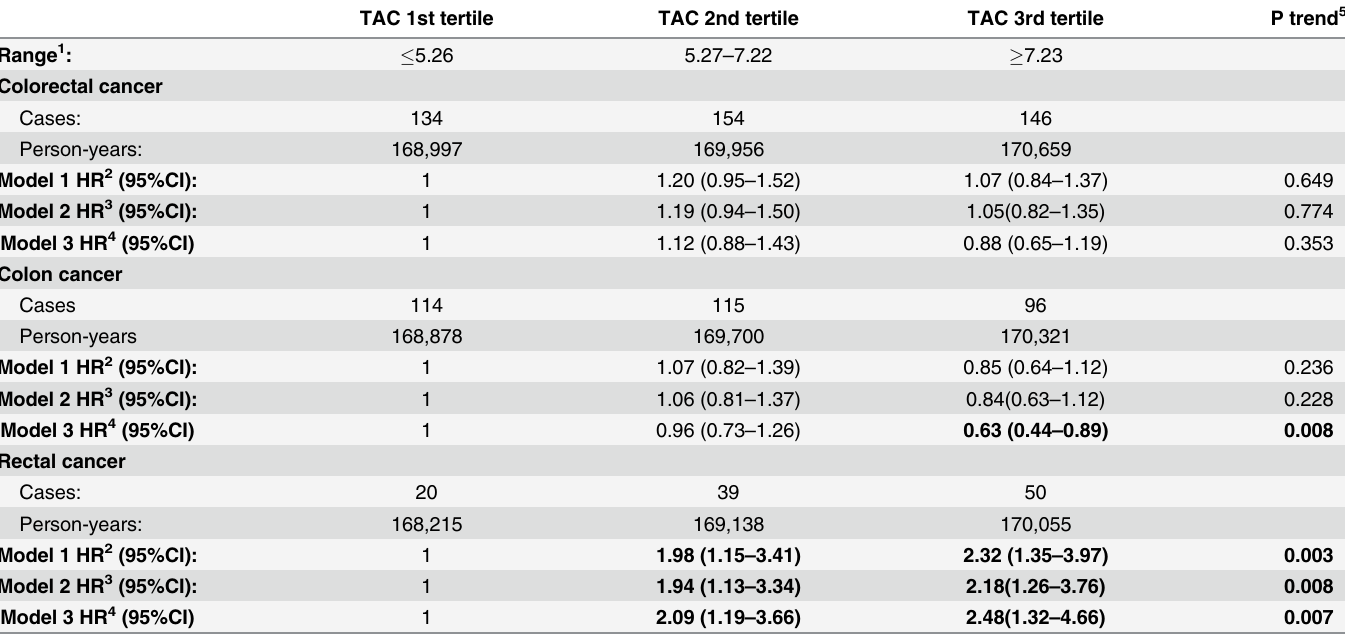
Table 2. HRs for developing colorectal, colon and rectal cancer by increasing tertiles of dietary TAC. TAC 1st tertile TAC 2nd